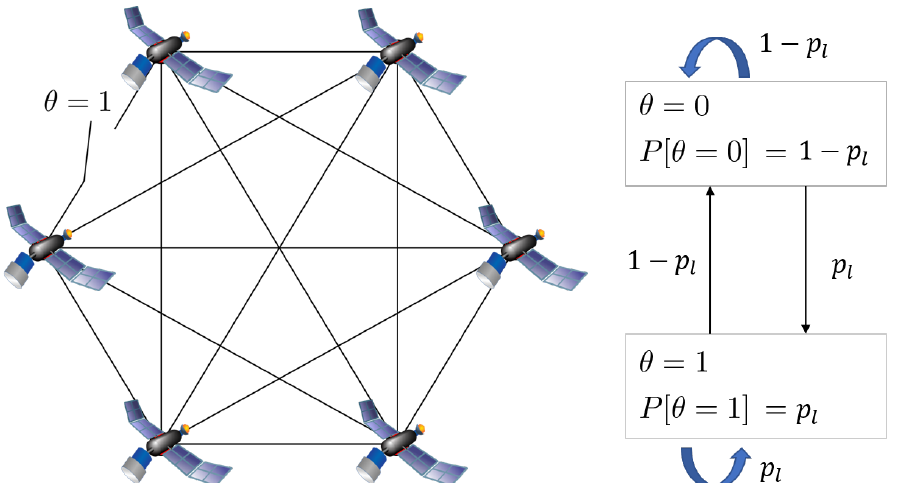
Figure 3. Node network modelled as two-state markov chain with equal loss probability p l for both states θ .